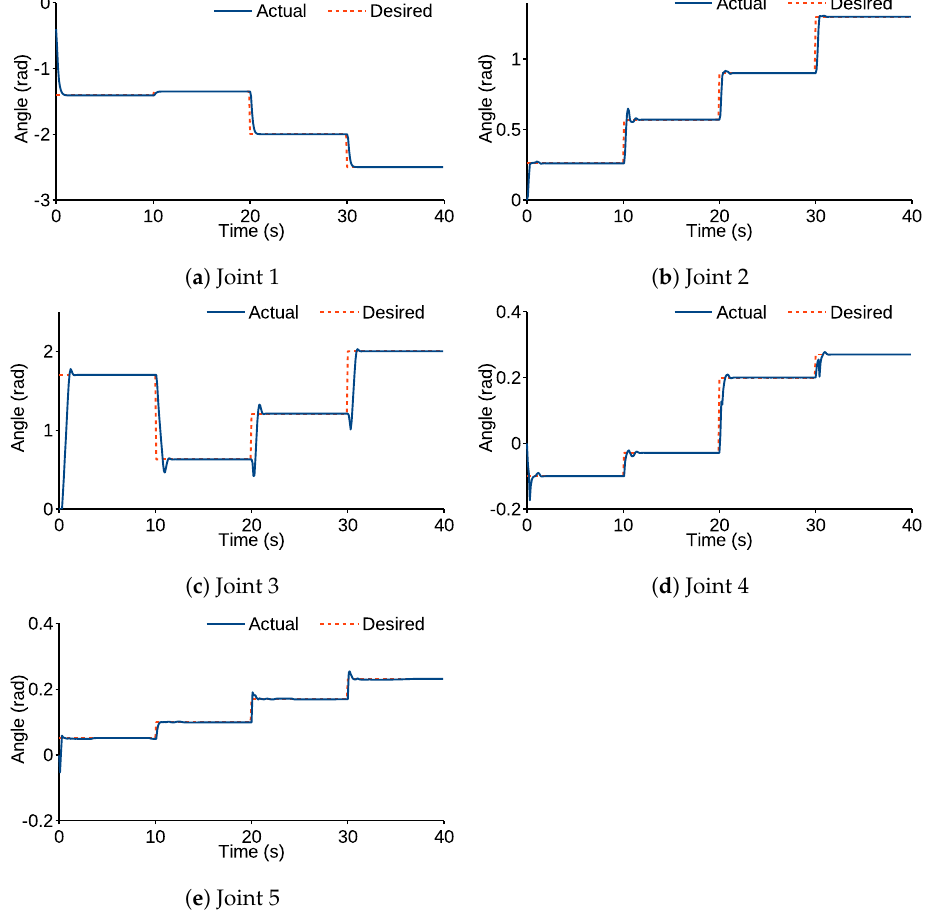
Figure 6. Performance of LAC for robotic model in virtual